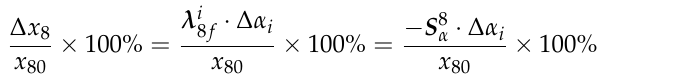
Figure 11. The change of x 8 with return oil part parameter varieties by 10%.